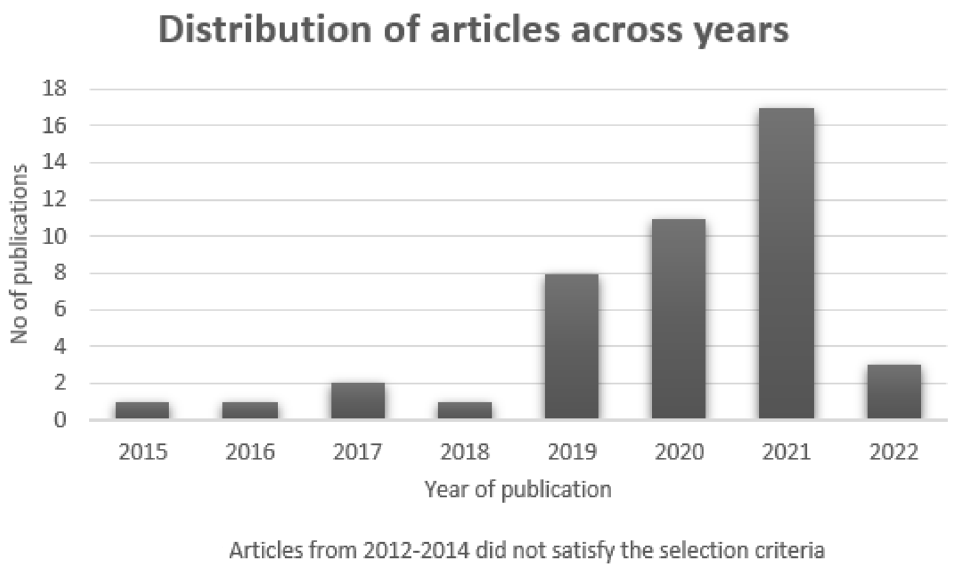
Figure 2. Distribution of articles between 2012 and 2022. Table 2. Summary of articles between 2012 and